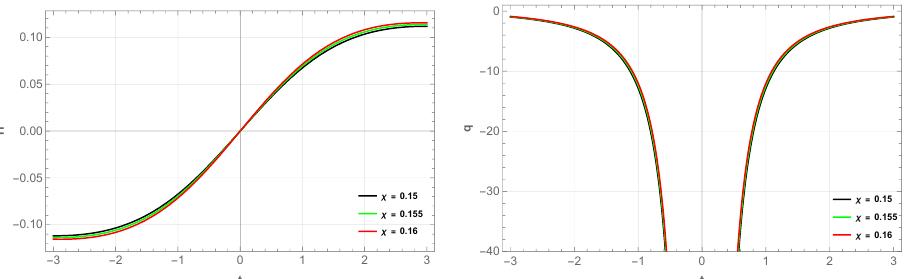
Figure 1. Behavior of Hubble parameter ( left panel ) and deceleration parameter ( right panel ) versus cosmic time t .